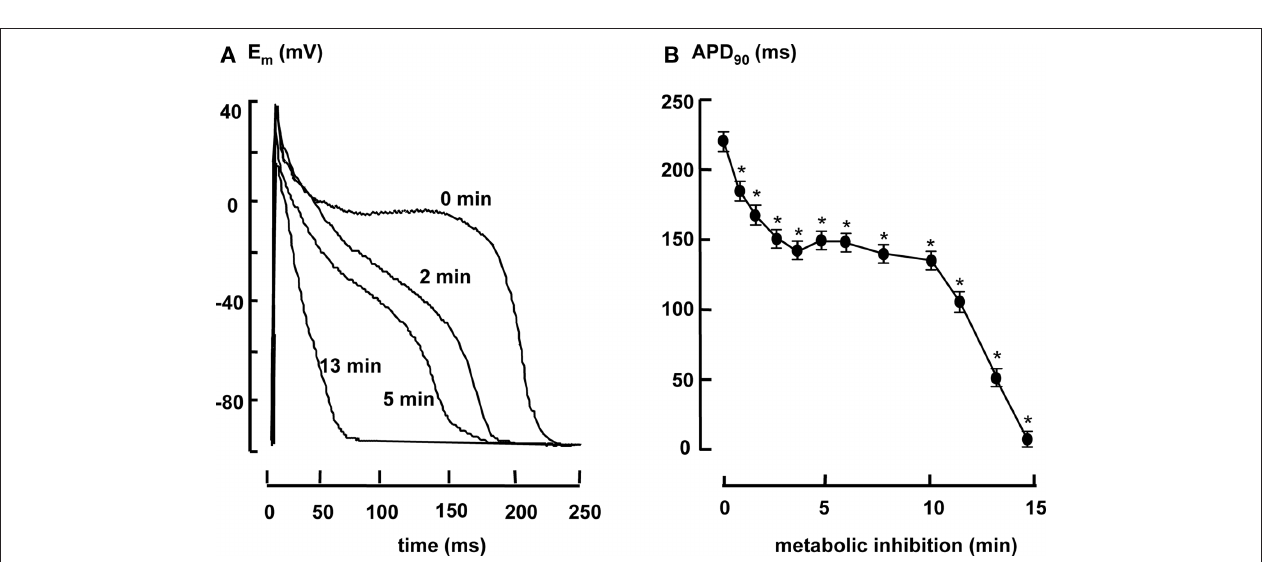
FiguRe 2 | (A) Representative examples of [Ca 2+ ] circles) and diastolic [Ca 2 + ]